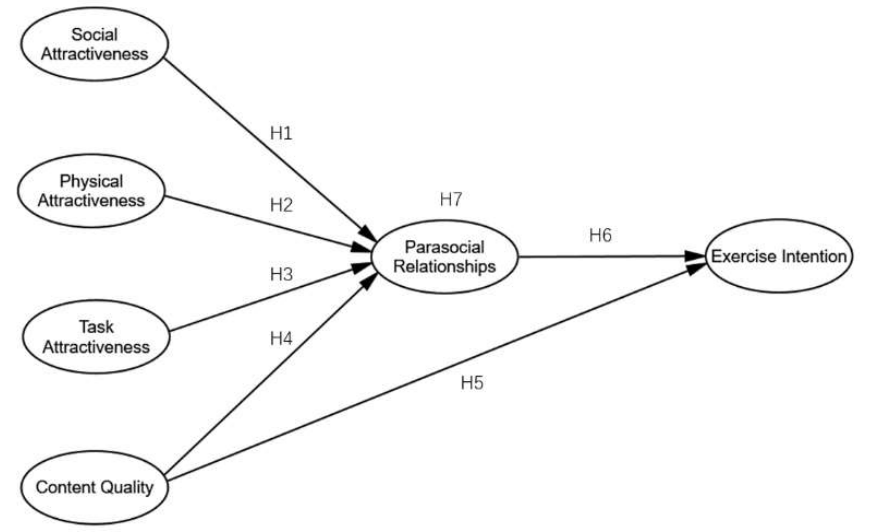
Figure 1. The research model.